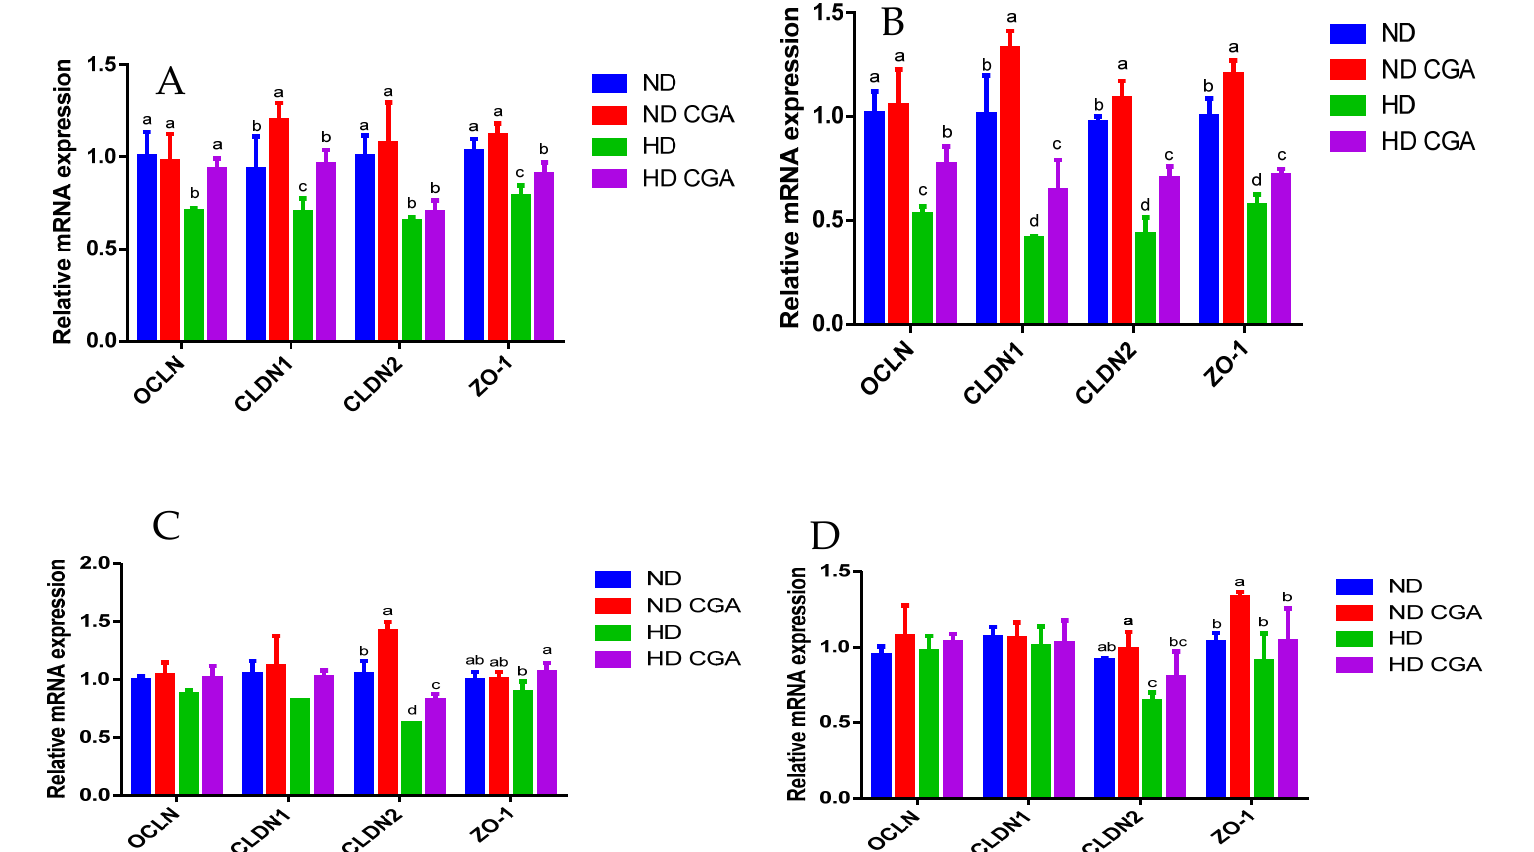
Figure 3. Effects of CGA on jejunal mRNA expression of tight junction genes in broilers under HD stress. ND group, normal stocking density + basal diet; ND + CGA group, normal stocking density + basal diet + 0.15% CGA; HD group, high stocking density + basal diet; HD + CGA group, high stocking density + basal diet + 0.15% CGA. ( A ) Relative mRNA expression at day 21. ( B ) Relative mRNA expression at day 28. ( C ) Relative mRNA expression at day 35. ( D ) Relative mRNA expression at day 42. Each vertical bar represents the mean ± SEM (n = 10). Values with different letters are significantly different ( p < 0.05, Tukey’s HSD test after one-way ANOVA).